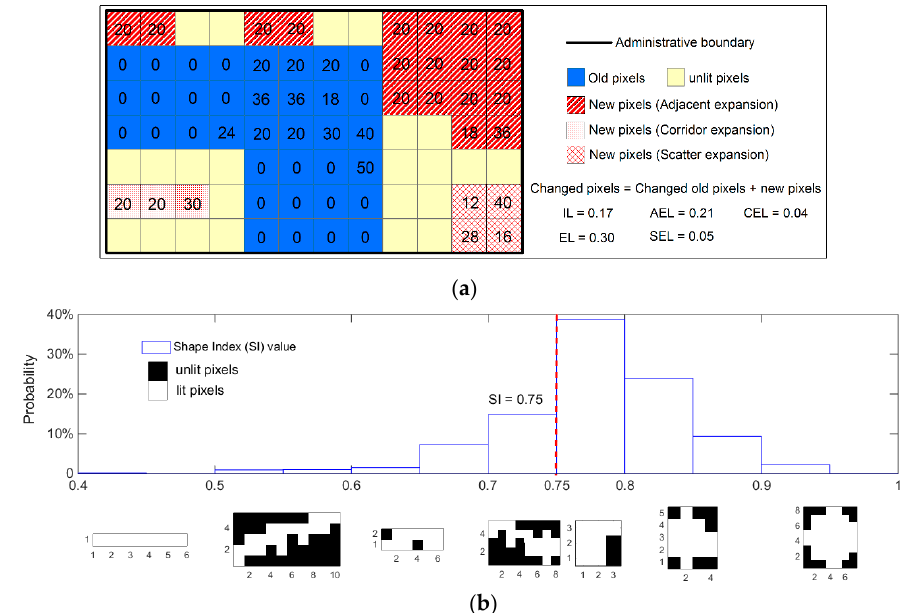
Figure 4. ( a ) An illustration of measuring intensification and expansion, where 3 agglomerations of adjacent expansion, 1 agglomeration of scatter expansion and 1 agglomeration of corridor expansion are identified; and ( b ) Probability distribution of SI with respect to different shapes of agglomerations, and a threshold value of 0.75 is determined via a direct visual observation on these dominant shapes.